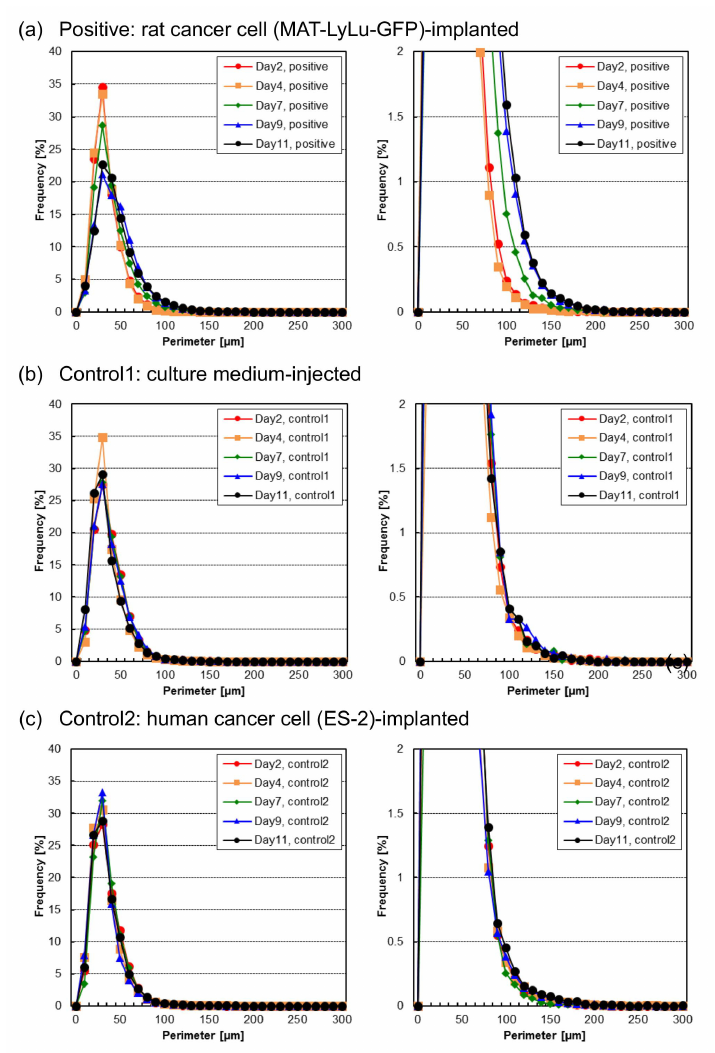
Figure 6. Perimeter length distribution of BF cell areas in positive ( a ), control 1 ( b ), and control 2 ( c ) blood of the same samples as in Figure 4. Each size distribution map indicates 2, 4, 7, 9, or 11 days after the implantation of rat cancer cells ( a , positive), culture medium ( b , control 1), or human cancer cells ( c , control 2). Measurements were performed for six rats for positive blood and three for each control. The perimeter length distribution graphs on the right are magnified graphs of those on the left, to emphasize the details of the time-course changes of frequencies of larger perimeter